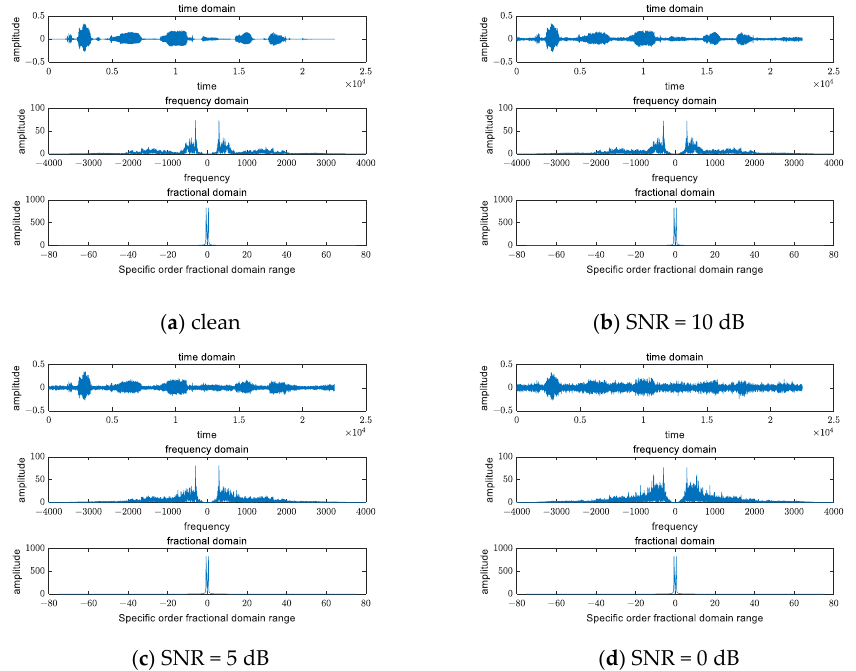
Figure 4. Spectrum comparison of signals with different SNRs in the fractional domain of the same transformation order. The simulation and comparison from Figure 3 verify that the fractional domain FT has energy aggregation characteristics for speech signals with different SNRs, and the en- ergy aggregation characteristics are not affected by noise. The advantages of the BSS sys- tem in the noise environment in the fractional domain are verified.